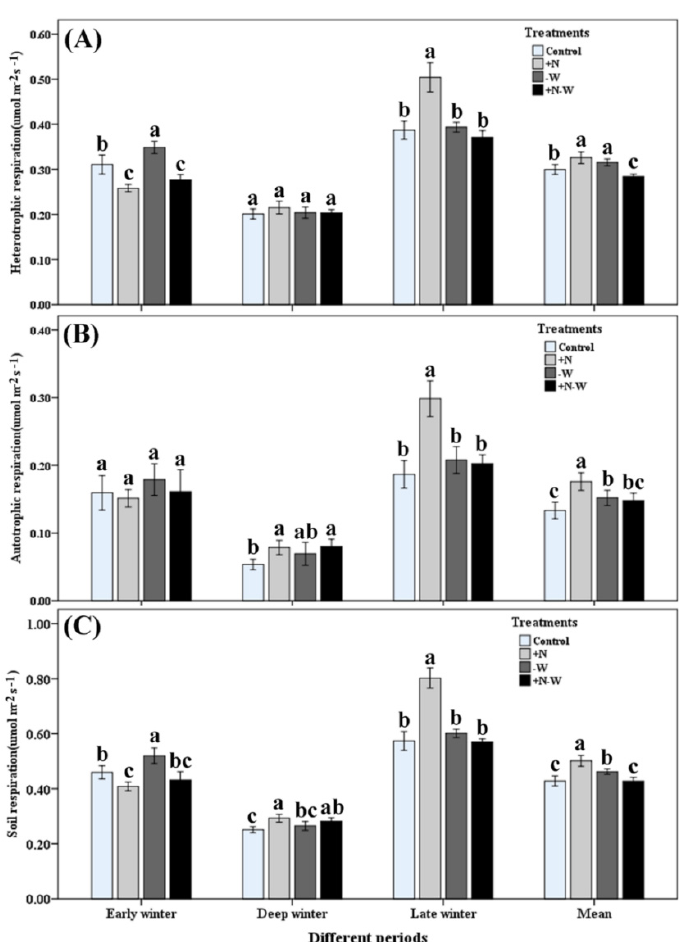
Figure 4. The effects of different treatments on total soil respiration ( C ), heterotrophic respiration ( A ), autotrophic respiration (B) and their mean value during the different periods in the nongrowing season of 2016/2017, 2017/2018, and 2018/2019. Significant differences among the different treatments are indicated by different letters. The error bars are standard errors. +N represents the N addition treatments; -W represents the precipitation reduction treatments; and +N-W represents the combined effect of N addition and precipitation reduction.